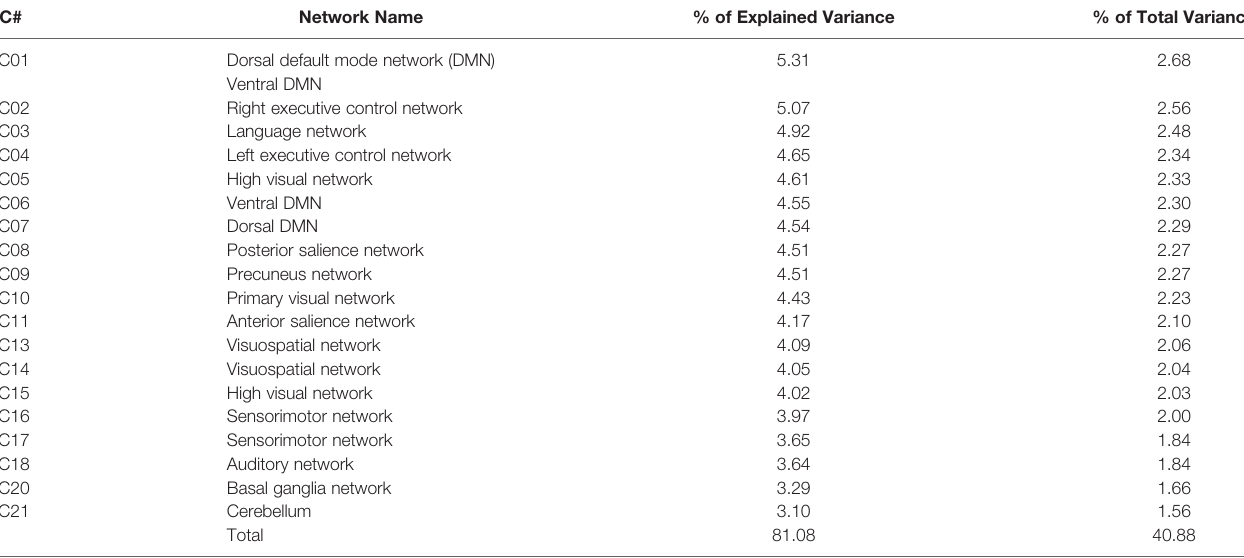
TABLE 1 | Independent components (ICs) from the Group Independent Component Analysis and Associated Resting-State